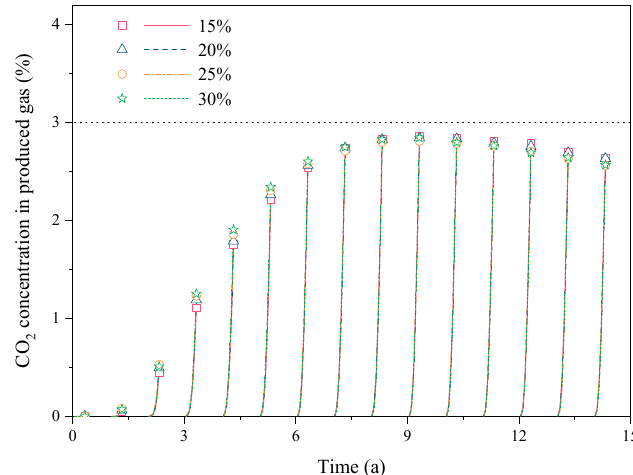
Figure 23. CO 2 concentration in the produced gas for different residual water saturations.